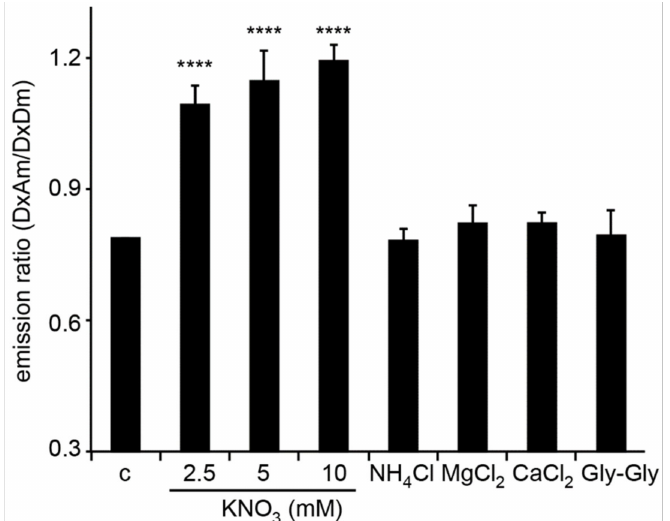
Figure 3. Emission ratio change of NiTrac-NPF1.3 specific to nitrate. Substrate specificity: Yeast cells expressing NiTrac-NPF1.3 were treated with the indicated compounds at 5 mM concentrations or as indicated in the figure. Only nitrate triggered responses that were significantly different from the control c (****, p < 0.0001, t -test). Experiment performed as in Figure 1. Nitrate triggers emission ratio changes with different nitrate concentrations. Nitrate-induced ratio change (peak fluorescence intensity of Aphrodite excited at 505 nm over emission spectrum at 485 nm obtained with excitation at 428 nm). Means and s.d.s of six biological repeats are presented (one-way ANOVA followed by Tukey’s